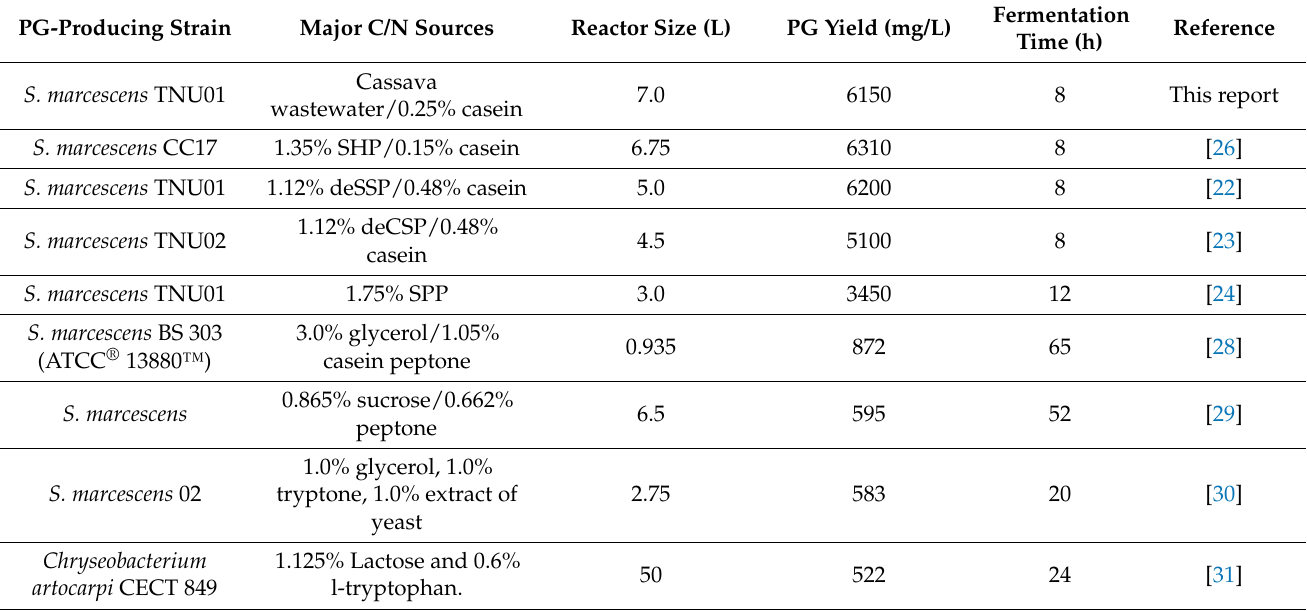
Table 2. Prodigiosin production, at a large scale, reported by various